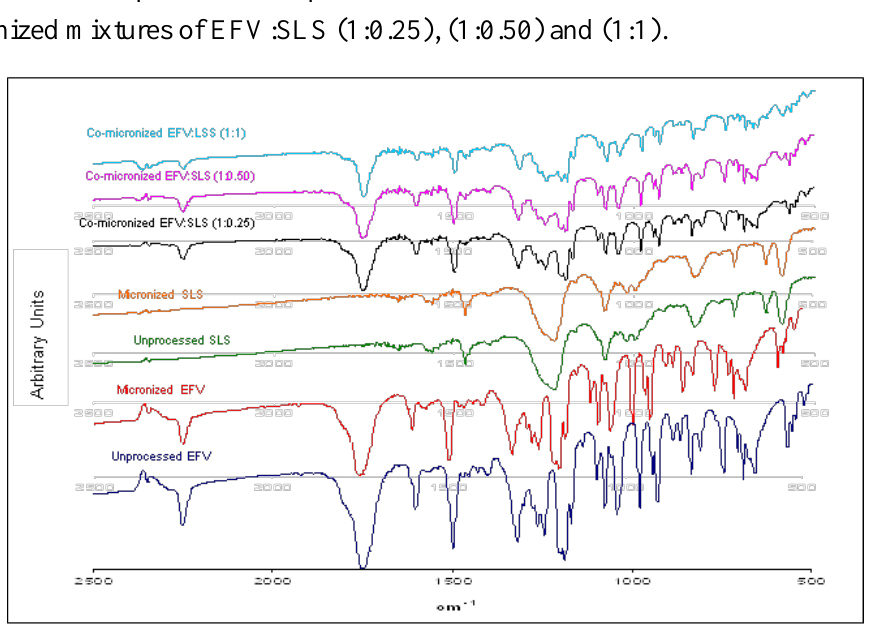
Figure 4. FITR spectra of unprocessed and micronized efavirenz and SLS